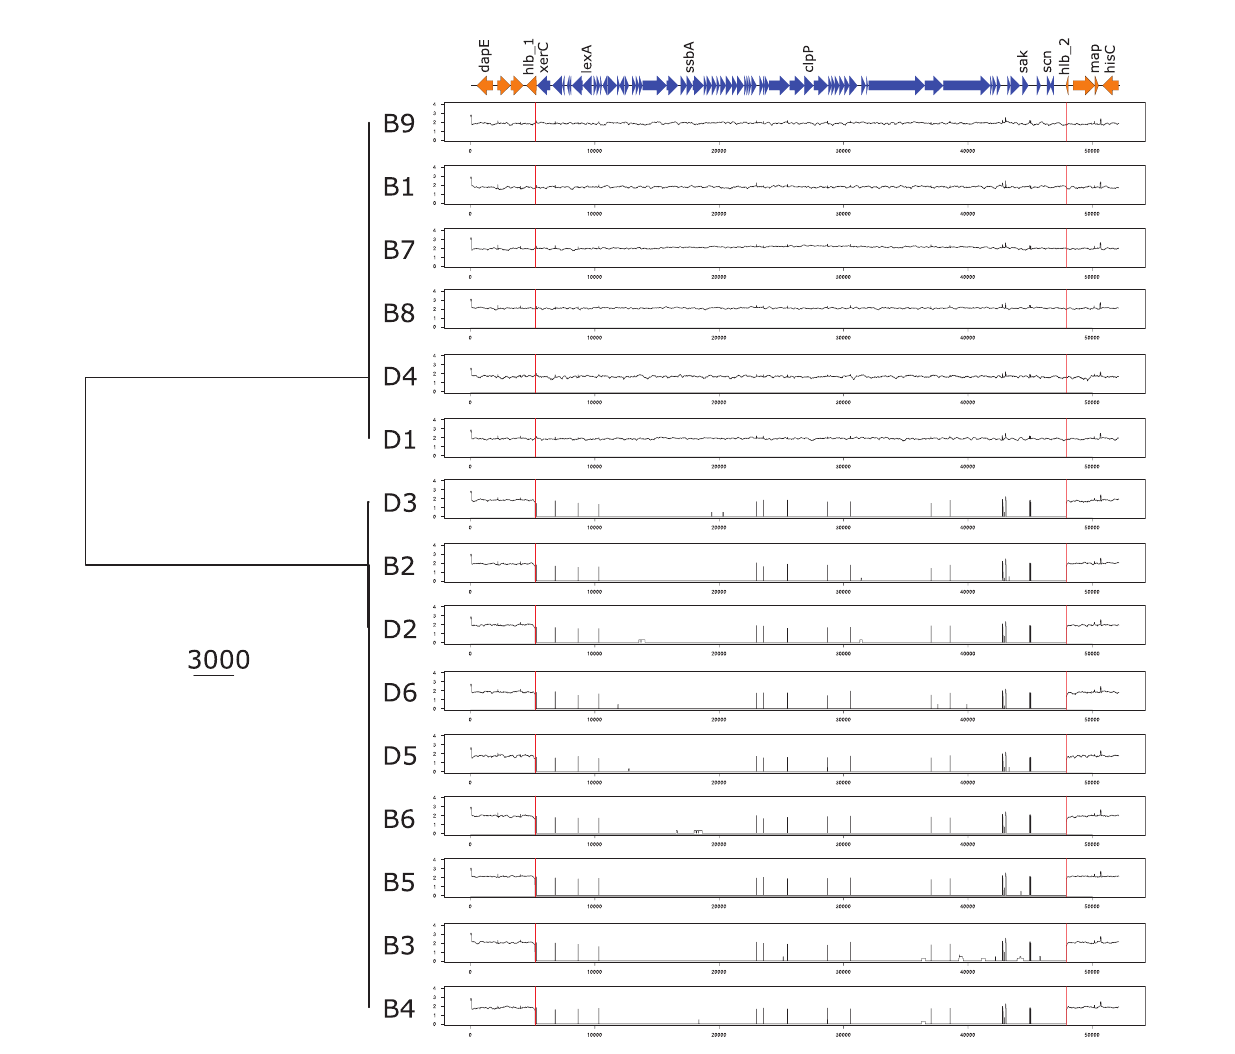
FIGURE 3 | UPGMA phylogenetic tree based on the nucleotide sequence of the prophage and the surrounding genomic context. UPGMA phylogenetic tree based on the nucleotide sequence of the prophage and the hlb genetic environment containing the integration site of the prophage based on reads mapping analysis. dapE , probable succinyl-diaminopimelate desuccinylase; hlb , hemolysin b; xerC , tyrosine recombinase; lexA , LexA repressor; ssbA Staphylococcus aureus , single- stranded DNA-binding protein; clpP , ATP-dependent Clp protease proteolytic subunit; sak , staphylokinase; scn , staphylococcal complement inhibitor; map , Major histocompatibility complex class II analogue protein; lucC , siderophore biosynthesis